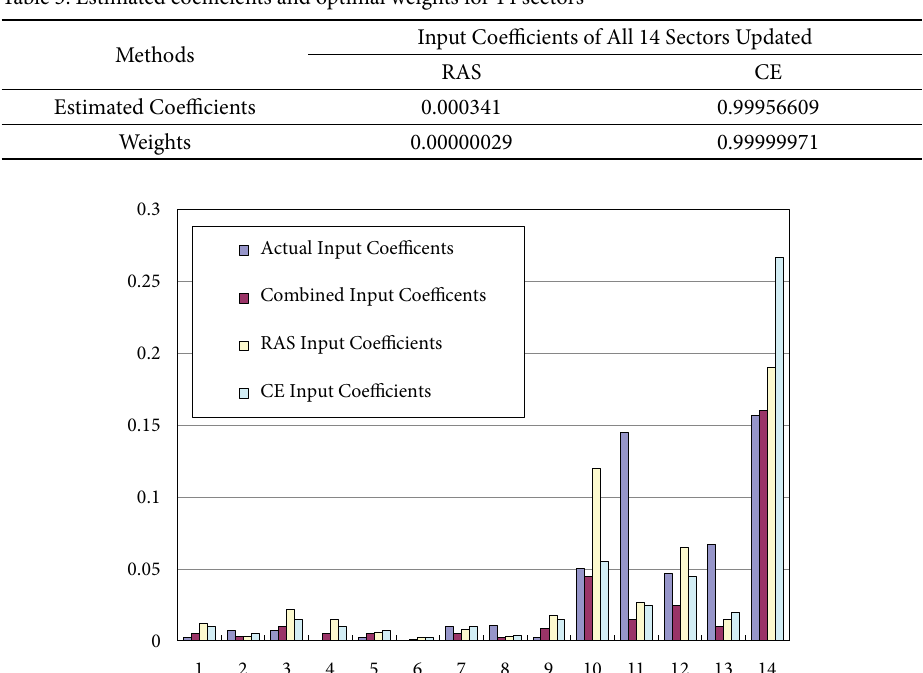
Fig. 5. Comparison of the combined estimated input coefficient and actual input coefficient for the Korean IT service